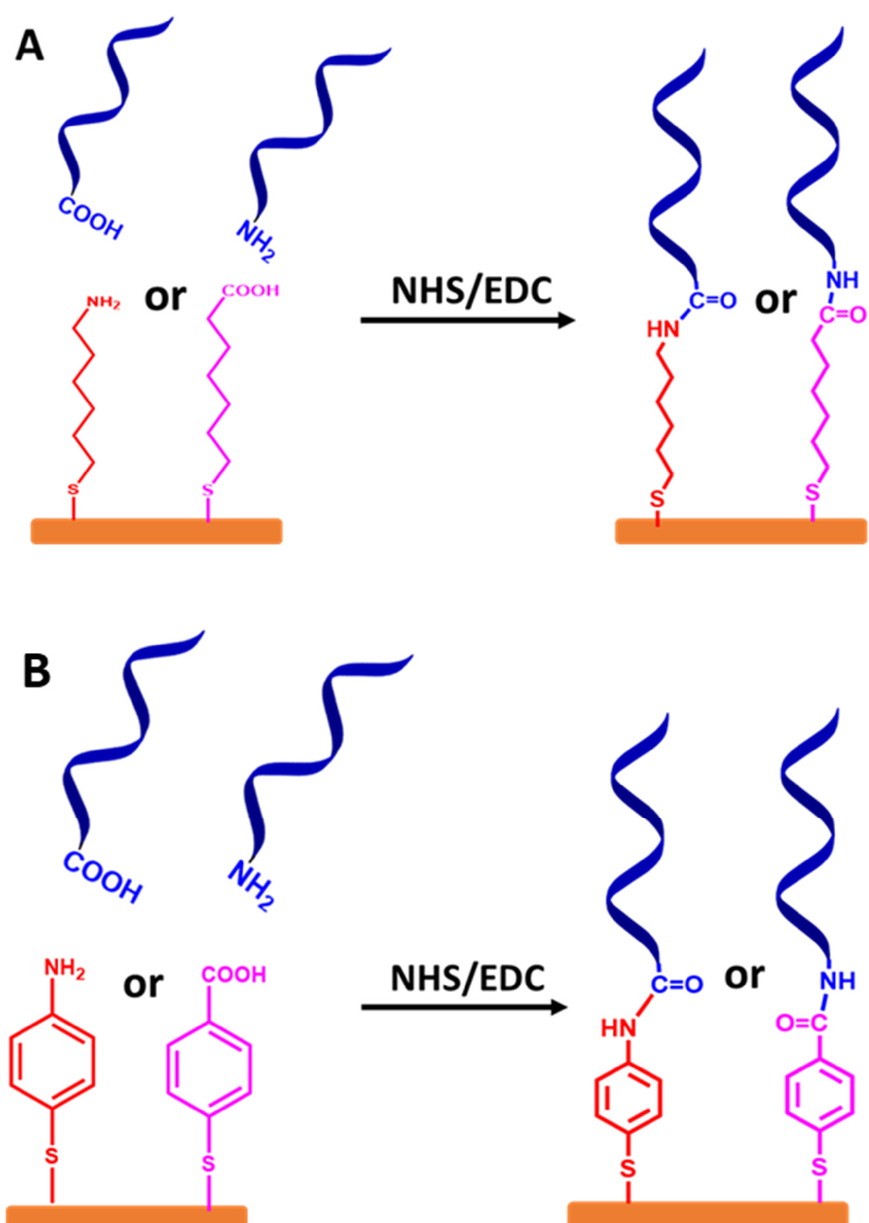
Figure 8. Schematic representation for stepwise protocols of self-assembled monolayer ssDNA chains onto the gold electrode surfaces via functionalized organic linkers with thiol groups, followed by coupling ssDNA chains to the linkers using NHS and EDC coupling reagents. ( A ) Self-assembled monolayer of ssDNA chains via thiolated alkyl linkers and ( B ) self-assembled monolayer of ssDNA chains via thiolated aromatic linkers. The relative sizes of gold electrodes, thiolated alkyl and thiolated aromatic linkers, and ssDNA chains are not to scale.